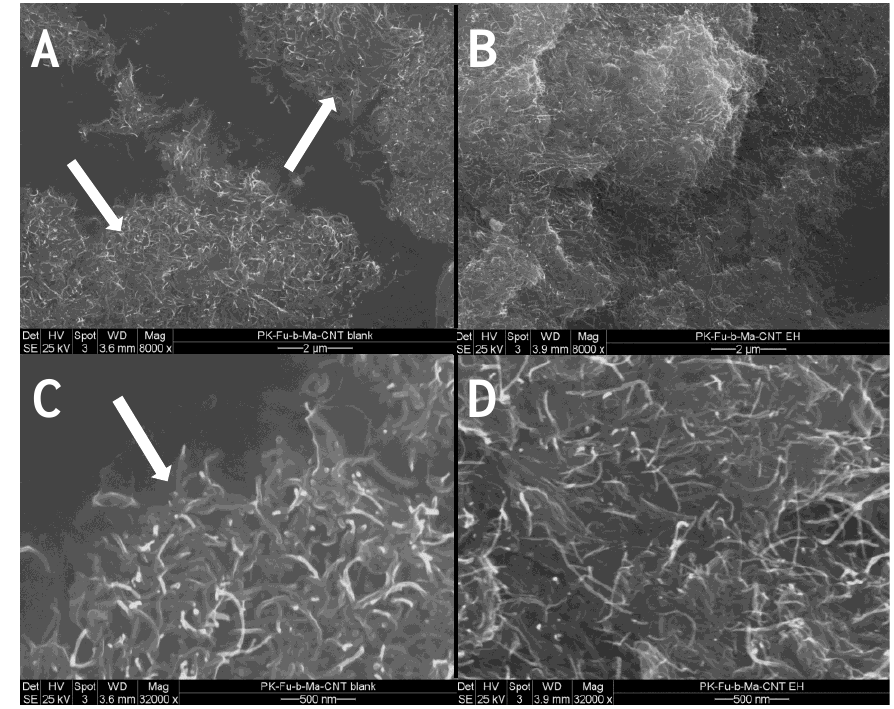
Figure 11. SEM micrographs of PK-Fu/B-Ma/MWCNTs reversible crosslinked composite after moulding ( A , C ) and after annealing by resistive heating ( B , D ).